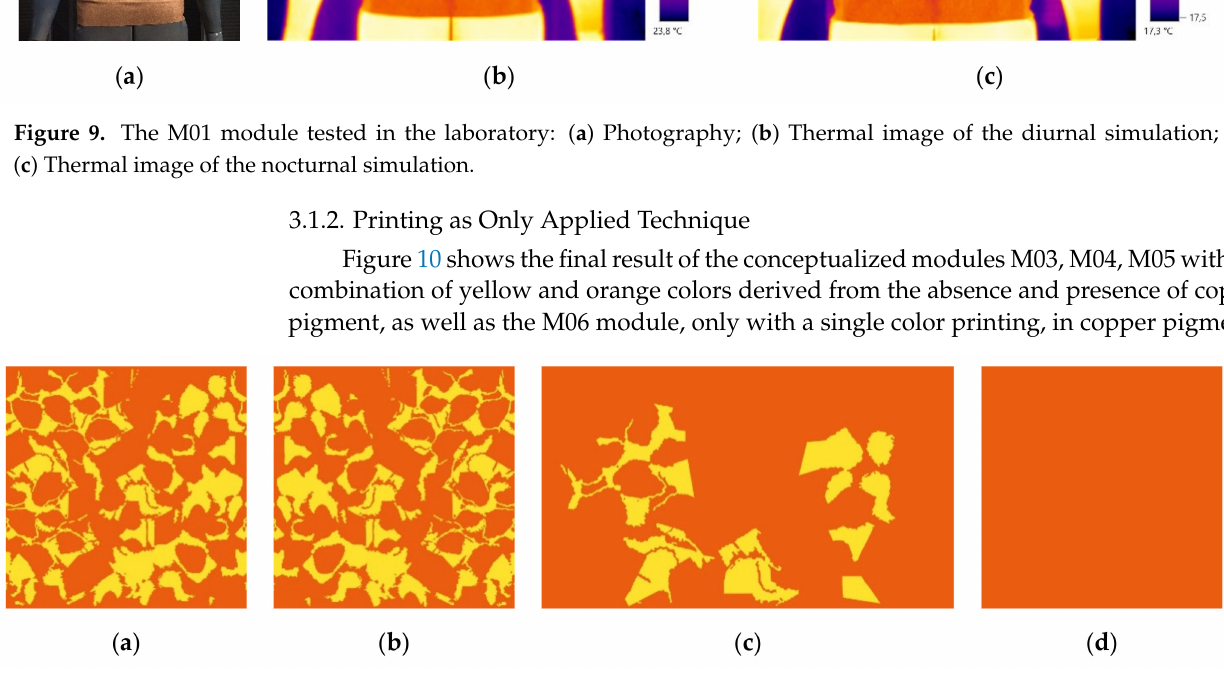
Figure 10. Pattern modules conceptualized with printed copper pigment: ( a ) M03; ( b ) M04; ( c ) M05; ( d )